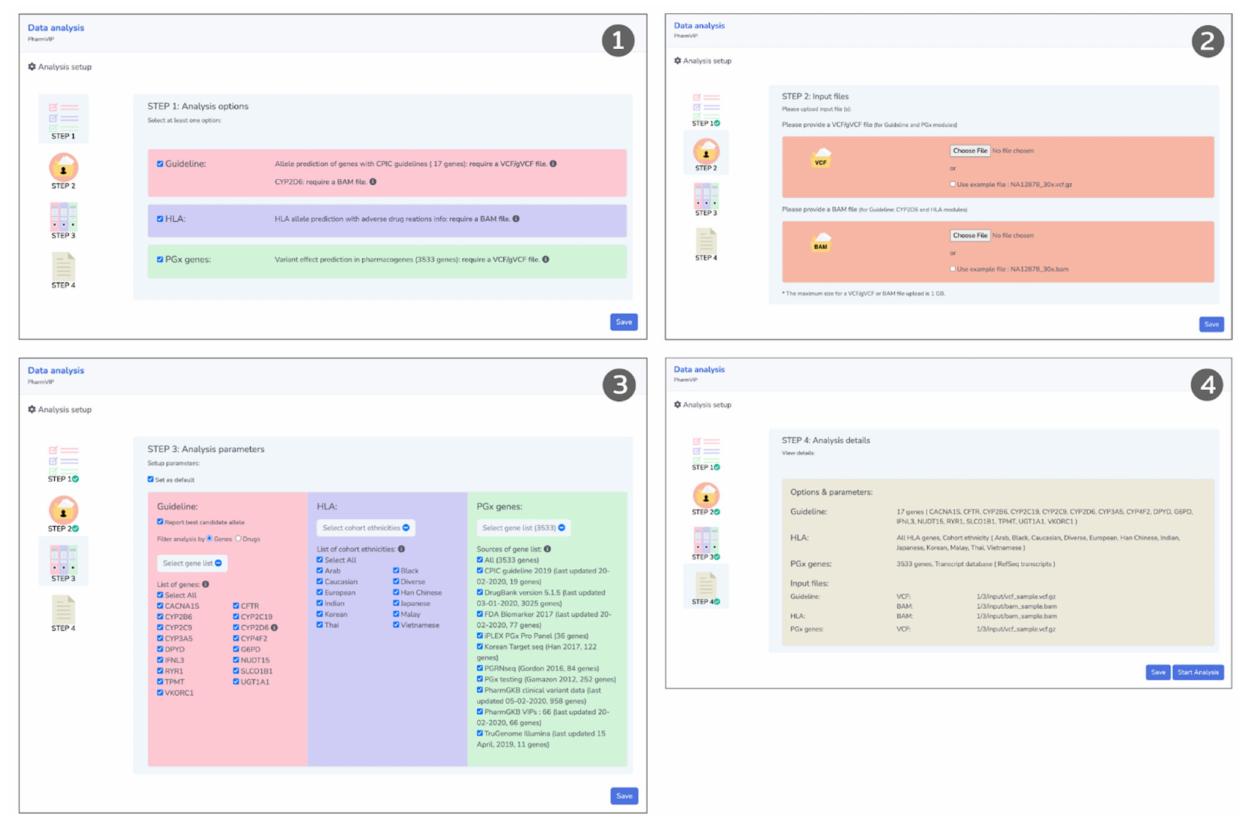
Figure 3. Four-step walkthrough of variant analysis. In step one, the user selects the desired analysis module(s). In step two, the user provides the corresponding input file(s). In step three, the user configures options for each of the selected analysis modules. In step four, the user verifies the chosen options before starting the